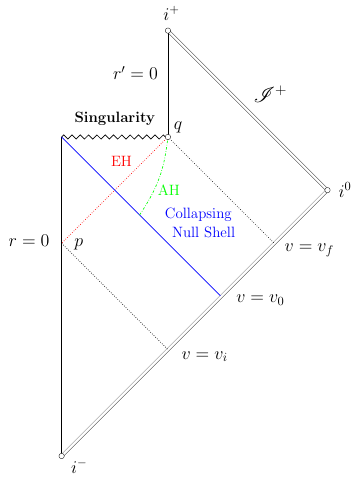
Figure 2 . The Penrose diagram of a four-dimensional spherically symmetric evaporating black hole which is formed by a collapsing null dust shell. The (red) dotted line and the (green) dashed- dotted line represent, respectively, the event horizon and the apparent horizon. The (blue) solid line represents the collapsing null dust shell, which is characterized in terms of the advanced null coordinate v as v = v 0